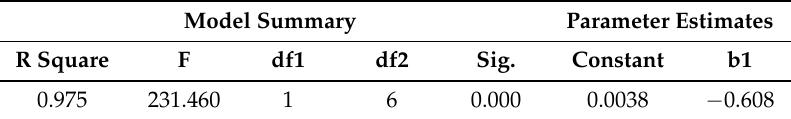
Table 10. Results of regression analysis between GHG emissions and weight of cargo truck load in tons, based on units of ACS area.